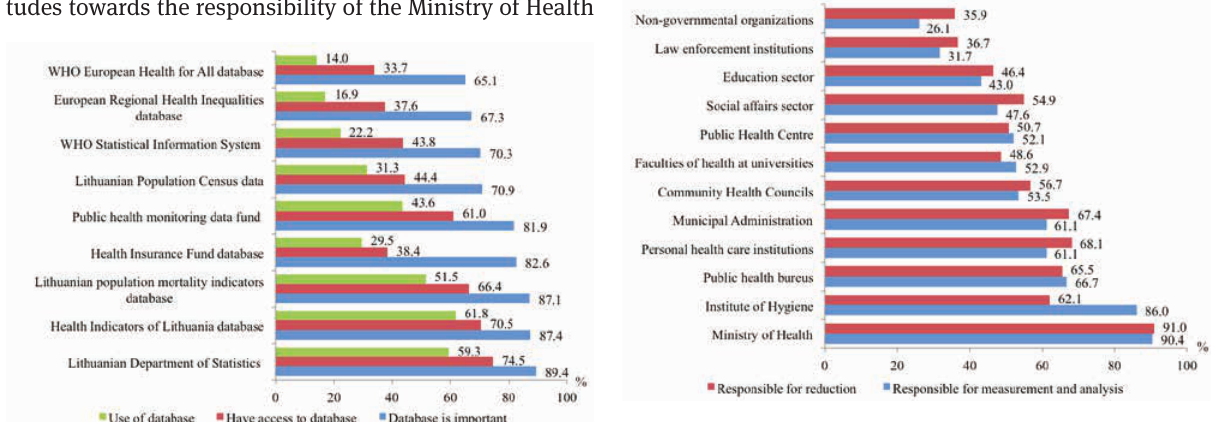
Figure 5: Respondents’ attitudes towards responsibility of institu- tions for measuring, analysing and reducing health inequalities